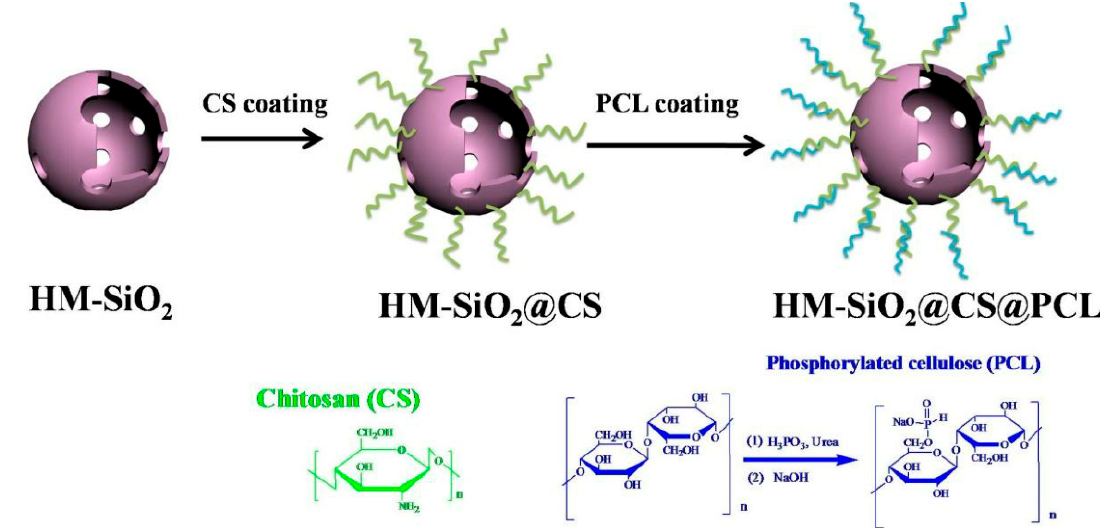
Figure 16. The synthetic route of HM-SiO2@CS@PCL. Readapted with permission from Ref. [149],